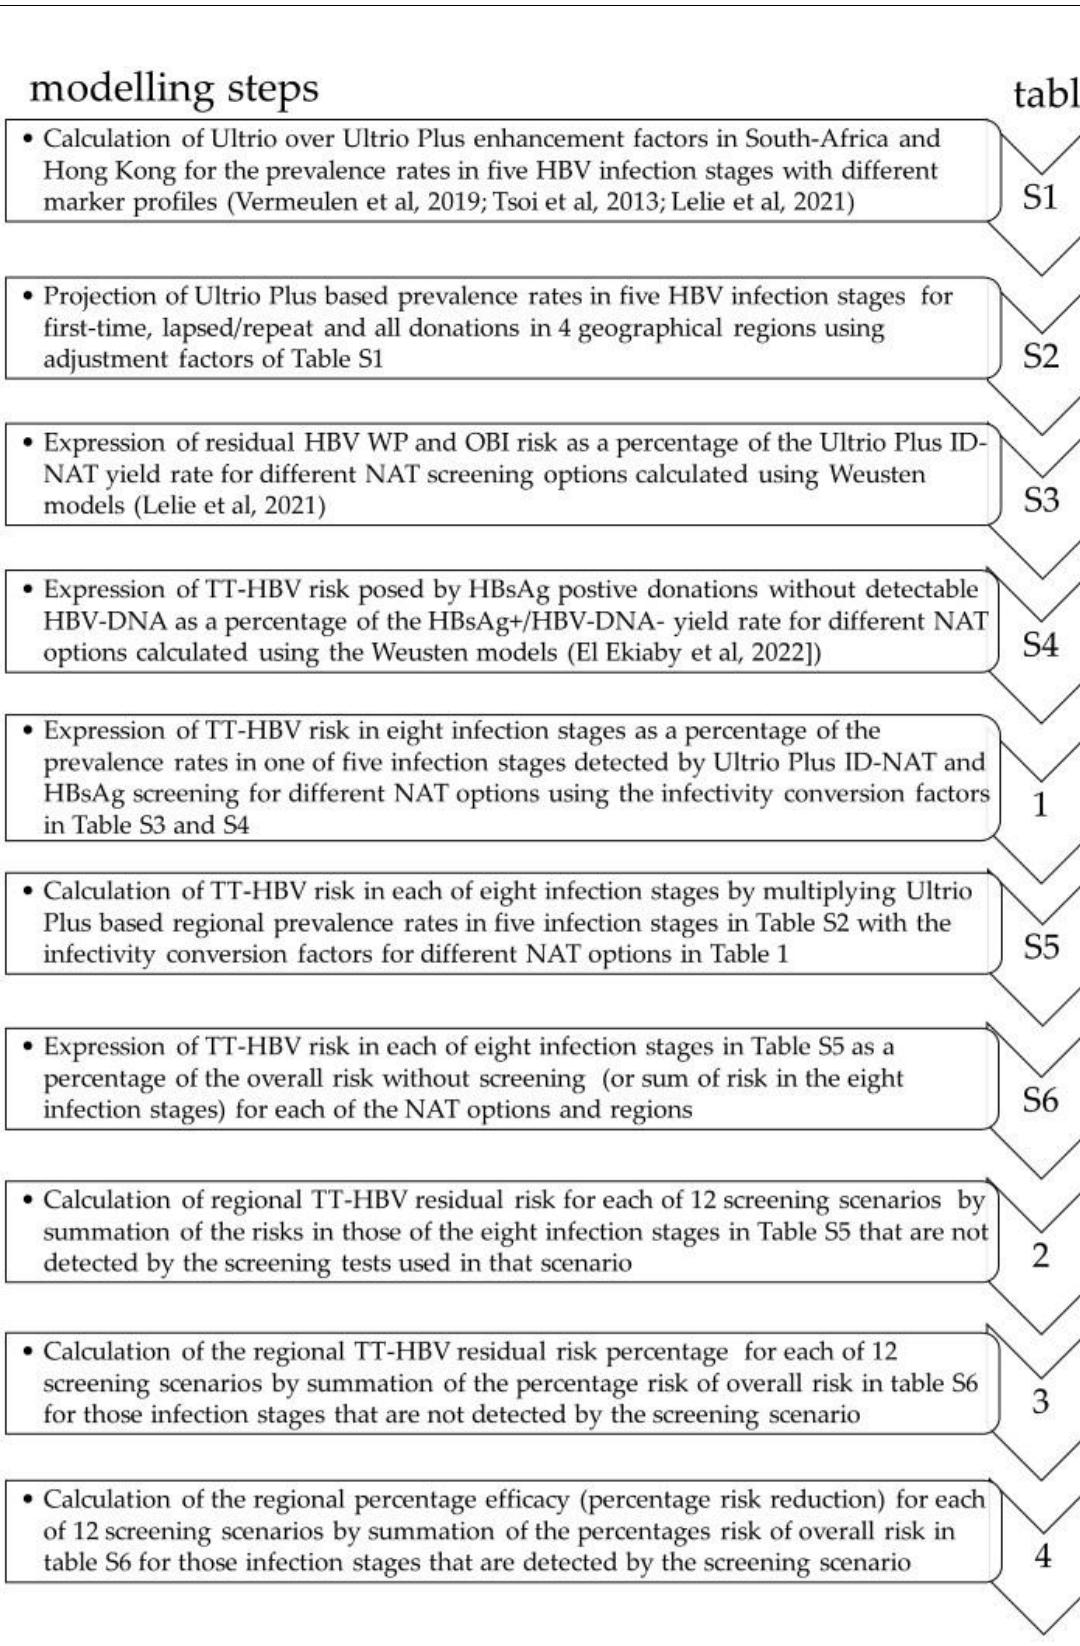
Figure 3. Subsequent modelling steps to estimate the efficacy of different testing scenarios in removing TT-HBV risk using screening data from four geographical regions. Each of the modelling steps is documented with a table in this report (i.e., Supplementary Tables S1–S6 and Tables 1–4).